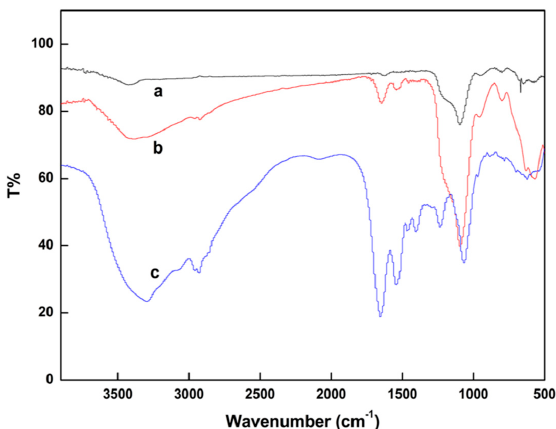
Figure 3. Fourier-transform infrared (FT-IR) spectra of Fe 3 O 4 / SiO 2 particles (a), Fe 3 O 4 / SiO 2 particles with bound PLD a2 (b), and PLD a2 (c).